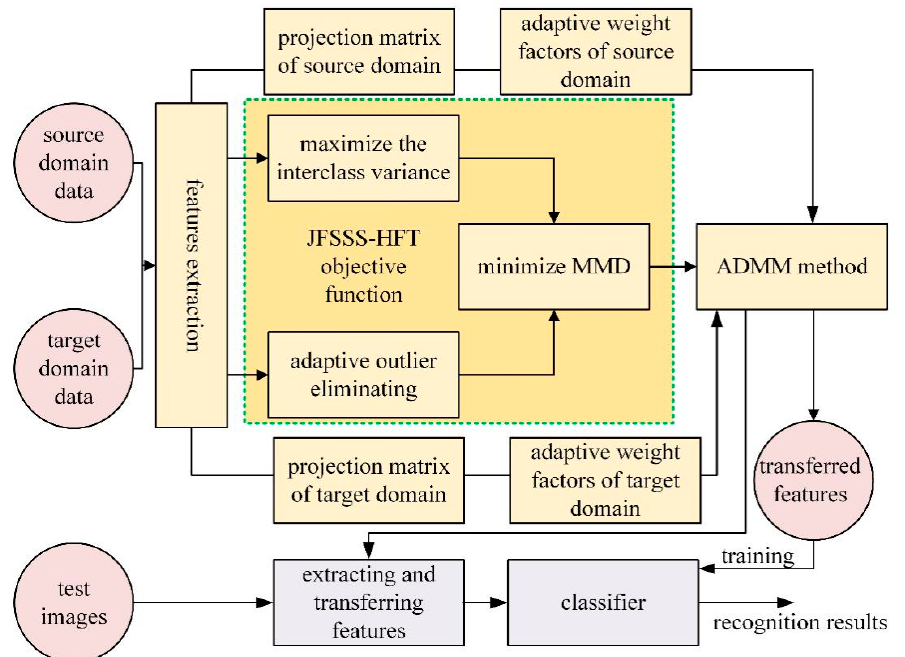
Figure 1. Illustration of the procedure of the proposed JFSSS-HFT for object recognition using RSIs from target domain and source domain.